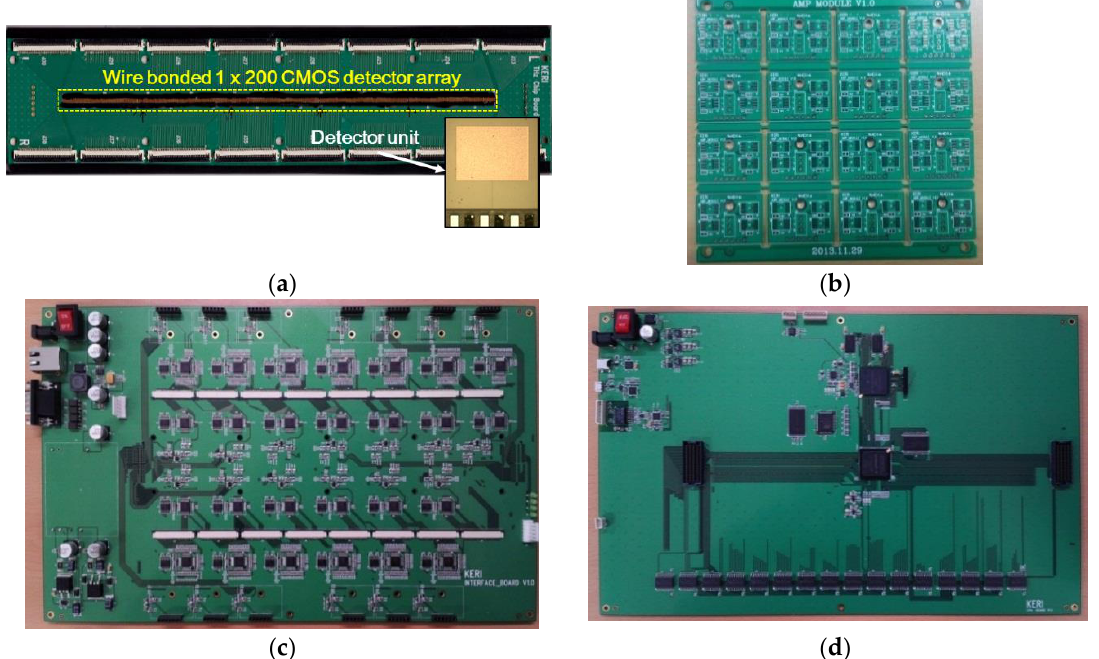
Figure 7. Photographs of ( a ) a 1 × 200 CMOS detector array board (size: 50 mm × 220 mm); ( b ) printed circuit boards (PCBs) for amplifier chain in the signal conditioning block (PCB unit size: 30 mm × 21 mm); ( c ) an interface board including ADCs, DACs, and multiplexers (MUXs) (size: 350 mm × 220 mm); and ( d ) a main controller and data acquisition board (size: 350 mm × 220 mm).